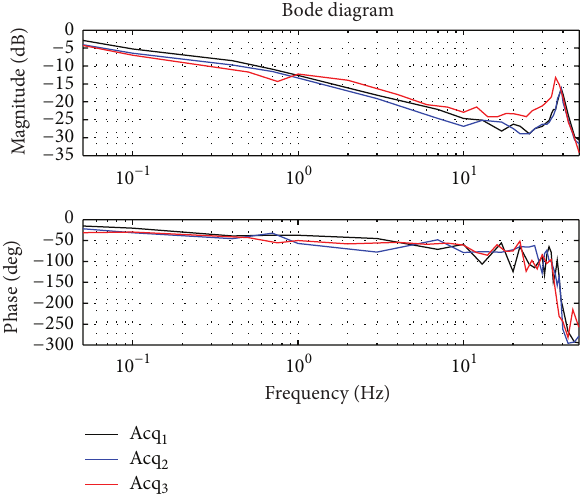
Figure 3: Magnitude and phase for the three acquisition